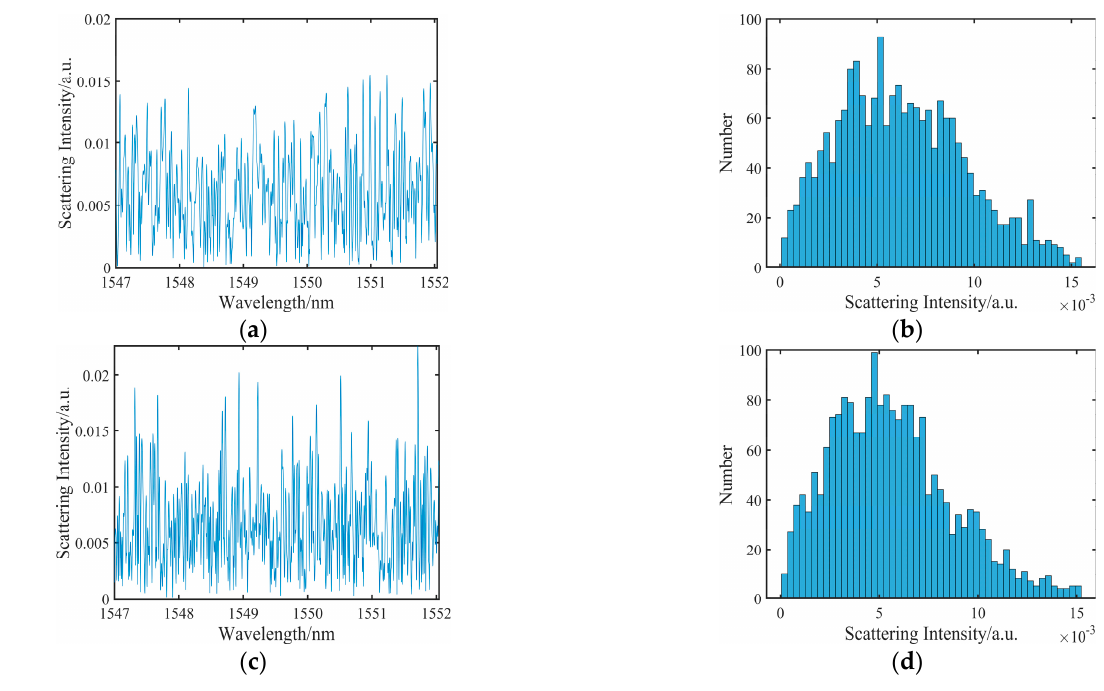
Figure 4. ( a )Experimental spectrum and ( b ) its Rayleigh sca tt ering distribution; ( c ) training Rayleigh sca tt ering spectrum and ( d ) its Rayleigh sca tt ering distribution.